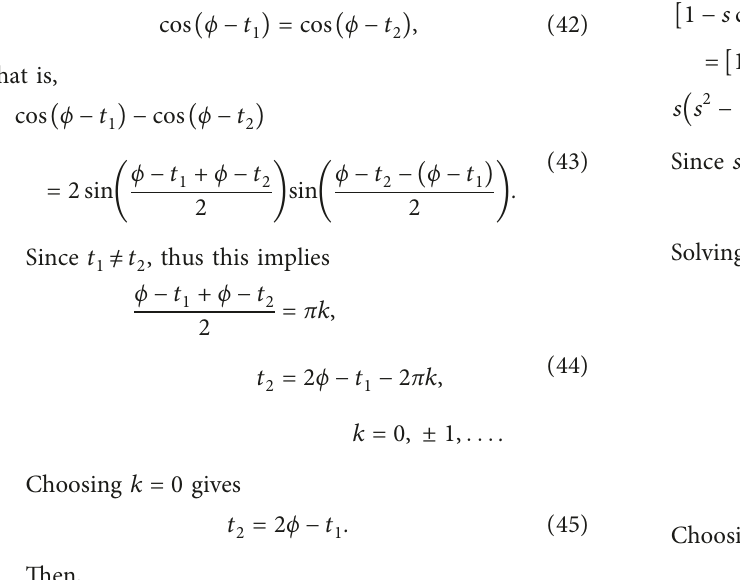
Figure 5: Graphs of g Example 3.